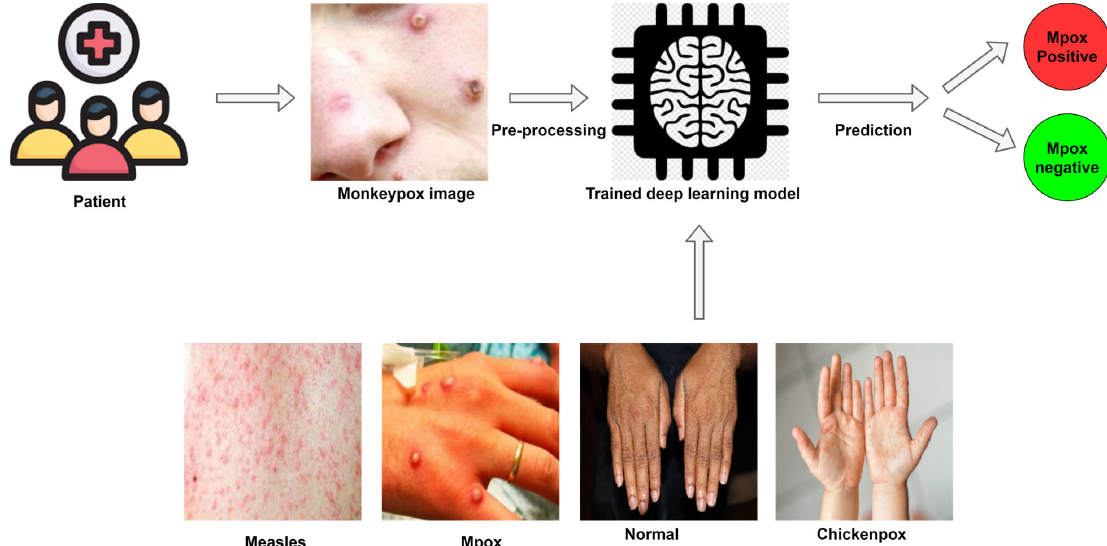
Figure 6. Deep learning ‐ based system which can be deployed to diagnose mpox virus. Alcala ‐ Rmz et al. [36] used a CNN model for mpox diagnosis. They implemented the MiniGoogLeNet for various epochs. The dataset comprised 2062 images, of which 1439 were chickenpox and measles images, and 1168 were mpox images. A maximum accuracy of 97.08% was attained when 50 epochs were used. Khafaga et al. [37] used a deep CNN to classify mpox images. The dataset from Kaggle consisted of 293 normal, 279 mpox, 107 chickenpox, and 91 measles cases. A maximum accuracy of 98.83% was attained. Haque